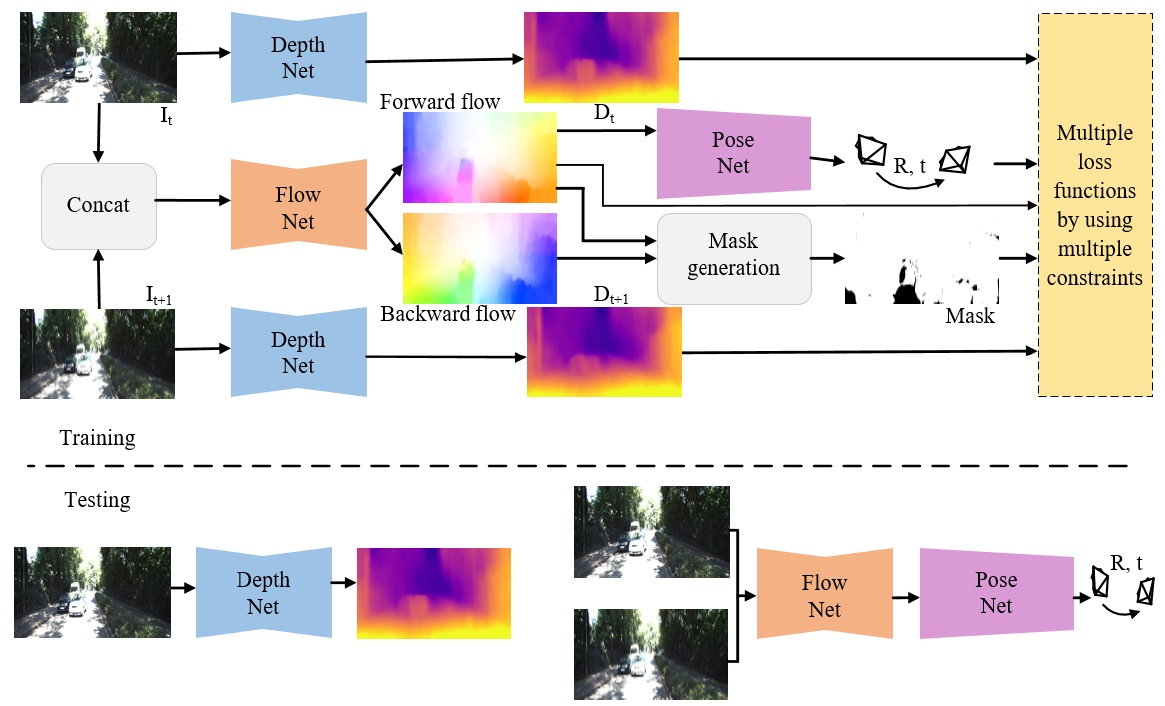
Figure 1. Overview of our method. During training, we use the unlabeled image sequences as the input of the network. FlowNet is an off-the-shelf optical flow estimation network to generate accurate OF fields. DepthNet and PoseNet are jointly trained for the prediction of the depth and pose. We exploit the forward-backward consistency check of the optical flow to mark the invalid region in the scene, so as to avoid the adverse effects of the outlier regions, such as occlusion regions and moving objects on training. Finally, we use multiple constraints as loss functions to train DepthNet and PoseNet. In the test stage, DepthNet and PoseNet are used to estimate the single-view depth and the 6-DOF camera pose separately.